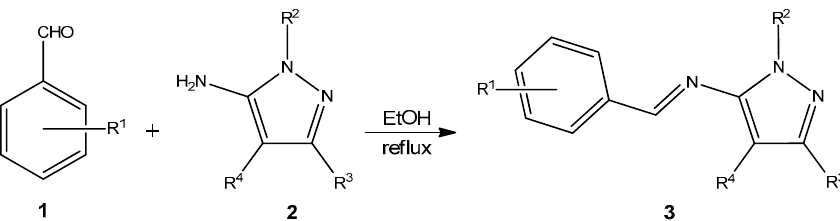
Figure 1. Customary synthesis scheme followed for the preparation of substituted pyrazolo-arylmethanimine derivatives.